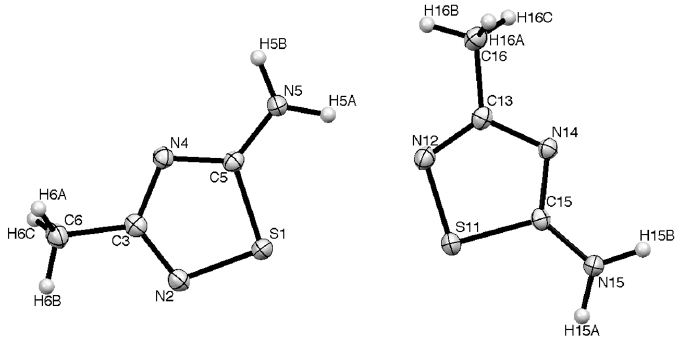
Figure 1. The two distinct molecules in the molecular structure of 1 with numbering scheme. Selected bond lengths and angles: S(1)-N(2) 1.682(1), N(2)-C(3) 1.317(2), C(3)-N(4) 1.374(2), N(4)-C(5) 1.333(2),